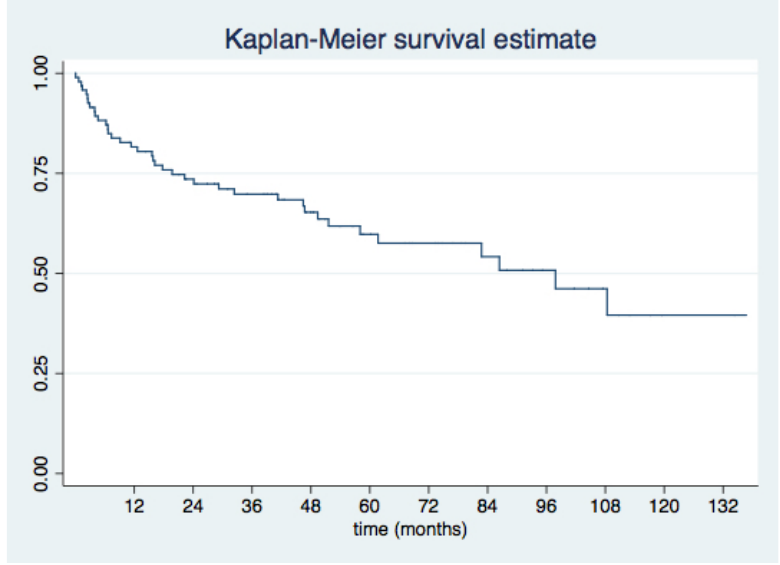
Figure 2. Overall survival after a first percutaneous mitral PVL closure procedure.